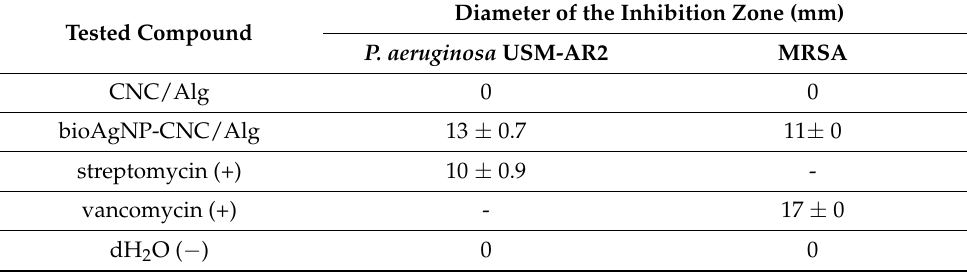
Figure 11. Disc diffusion test of the CNC/Alg hydrogel film ( A – C ) and the bioAgNP-CNC/Alg hydrogel film ( D – F ) against MRSA. BioAgNP-CNC/Alg and CNC/Alg are denoted (R), vancomycin is denoted (+), and dH 2 O is denoted ( − ). This test was conducted in triplicate. Table 3. Comparison of the diameter of the inhibition zone between the bioAgNP-CNC/Alg hydrogel film and the CNC/Alg hydrogel film against P. aeruginosa USM-AR2 and MRSA. The values presented are the means ± S.E. The difference in inhibition between the tested compounds was considered statistically significant according to one-way ANOVA at p < 0.05.